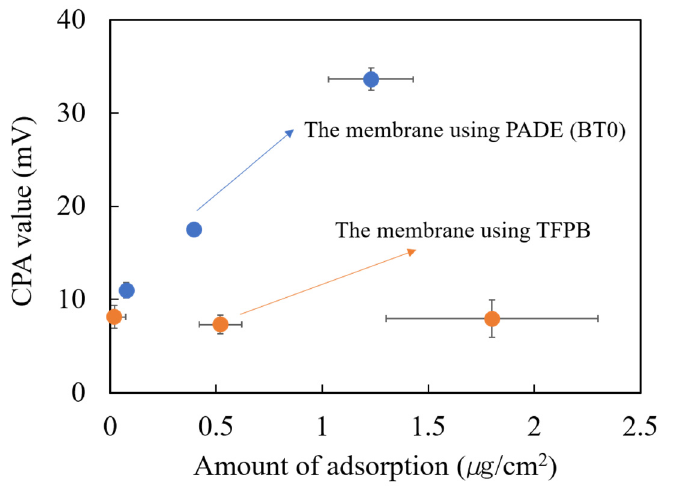
Figure 8. The change of CPA value with the amount of adsorption of quinine hydrochloride (0.1 mM) onto the membrane. The blue dots indicate the BT0 sensor and the orange dots indicate the sensor with the TFPB-BBPA-TBAC membrane. The results are expressed as means ± SD ( n = 6, 3 membranes (cid:3400) 2 times).